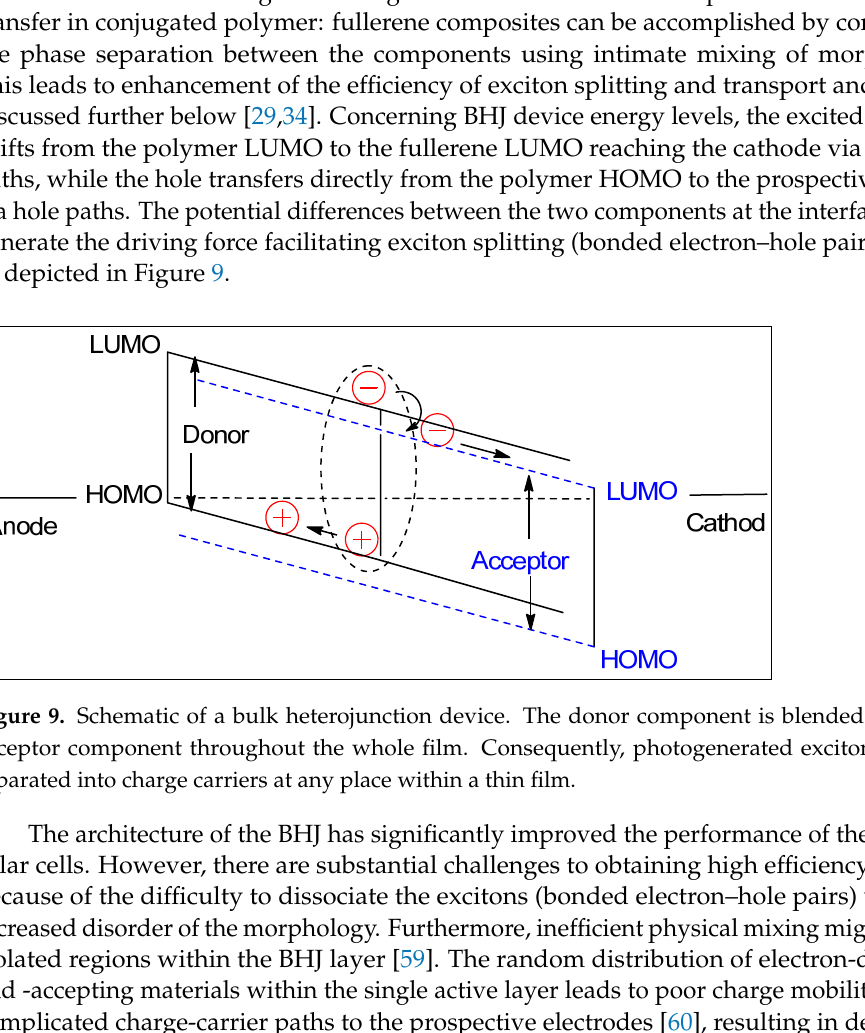
9 of 39 Figure 8. ( a ) Schematic of a bilayer organic structure. ( b ) Schematic of the phase separation of a bilayer device. The donor contacts the higher-work-function electrode and the acceptor contacts the lower-function electrode. 3.3. Bulk Heterojunction (BHJ) Device Yu et al . [29] introduced the concept of the BHJ device; it was constructed by blending two organic materials, i.e., a conjugated-polymer donor and fullerene-derivative acceptor. Under this concept, the most common method of the formation of the active layer is to disperse the acceptor component in the conjugated polymer. The method is achieved by